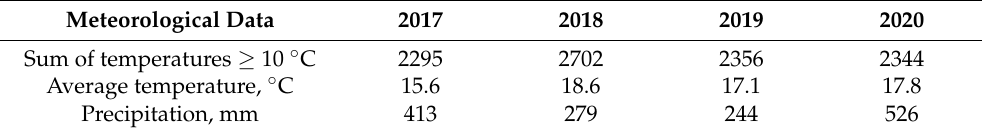
Table 2. Meteorological conditions during the quinoa growing season, April to October (data from the V.A. Mikhelson Observatory,